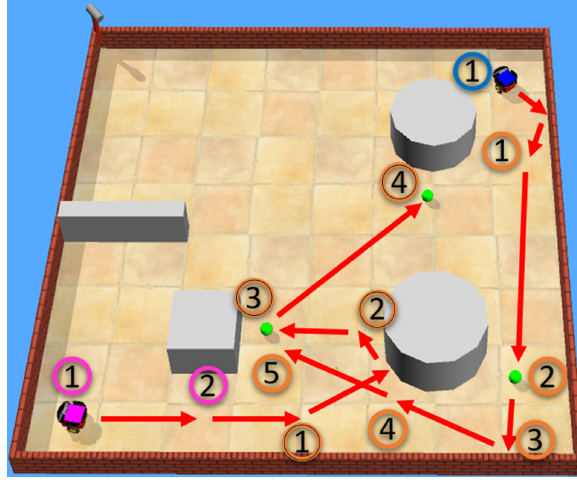
Figure 8. Experimental results made by Participant